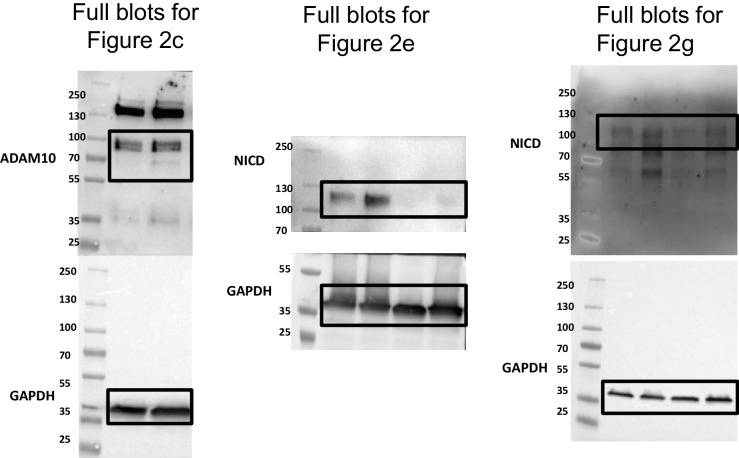
Uncropped western blots for Figure 2c, Figure 2e and Figure 2g.